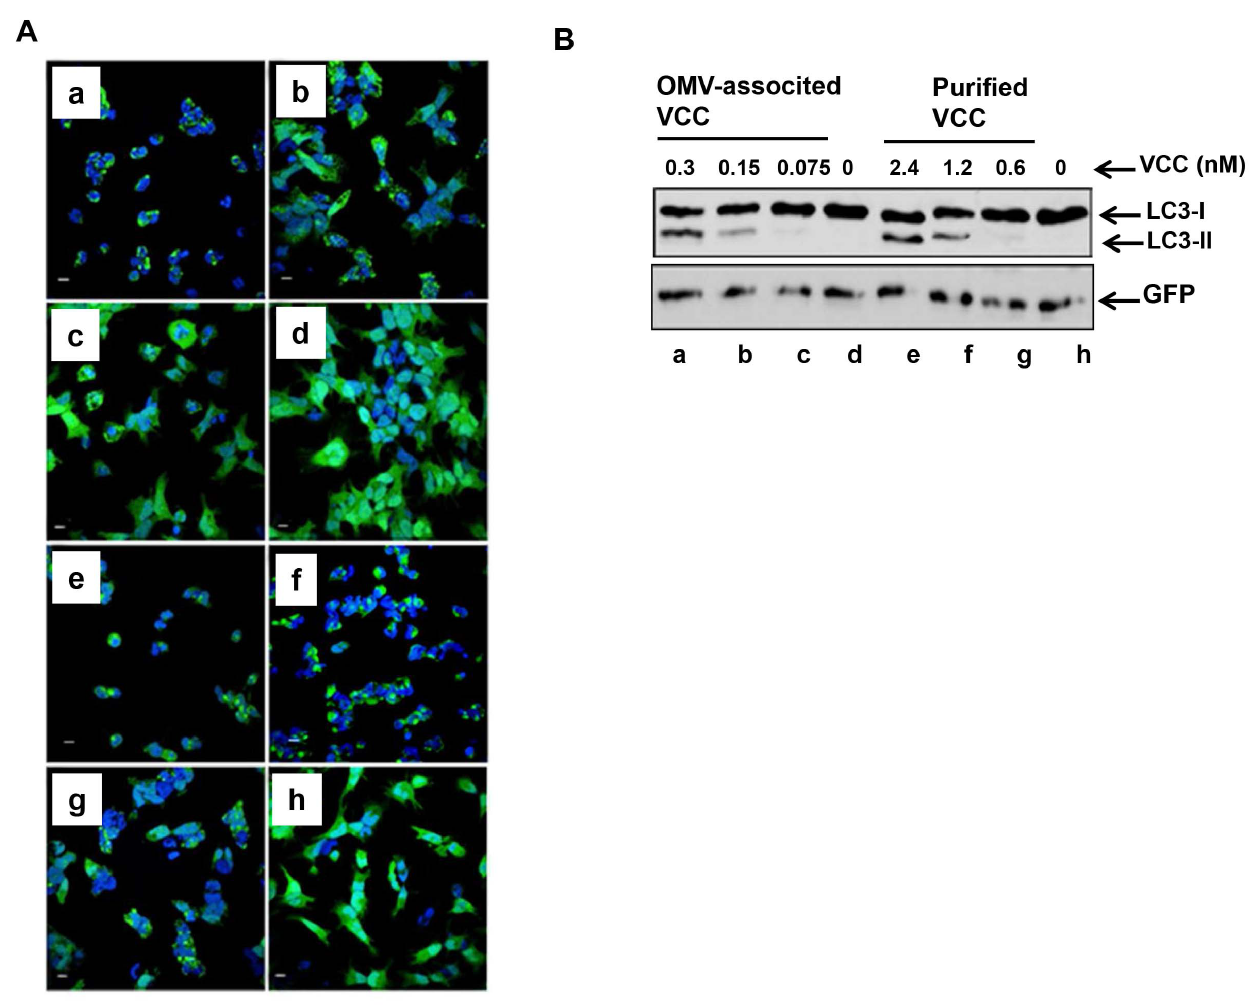
Figure 7. VCC induced autophagy. Confocal microscopy analysis (A) and immunoblot analysis (B) of autophagy induced by vesicle-associated VCC in HEK293 cells stably expressing a GFP::LC3 fusion protein. HEK293 cells were treated with: 0.3 nM, 0.15 nM, 0.075 nM of OMVs associated VCC (a, b, c); OMVs isolated from the D vcc mutant (d); 2.4 nM, 1.2 nM, and 0.6 nM of purified VCC respectively (e, f, g, h).